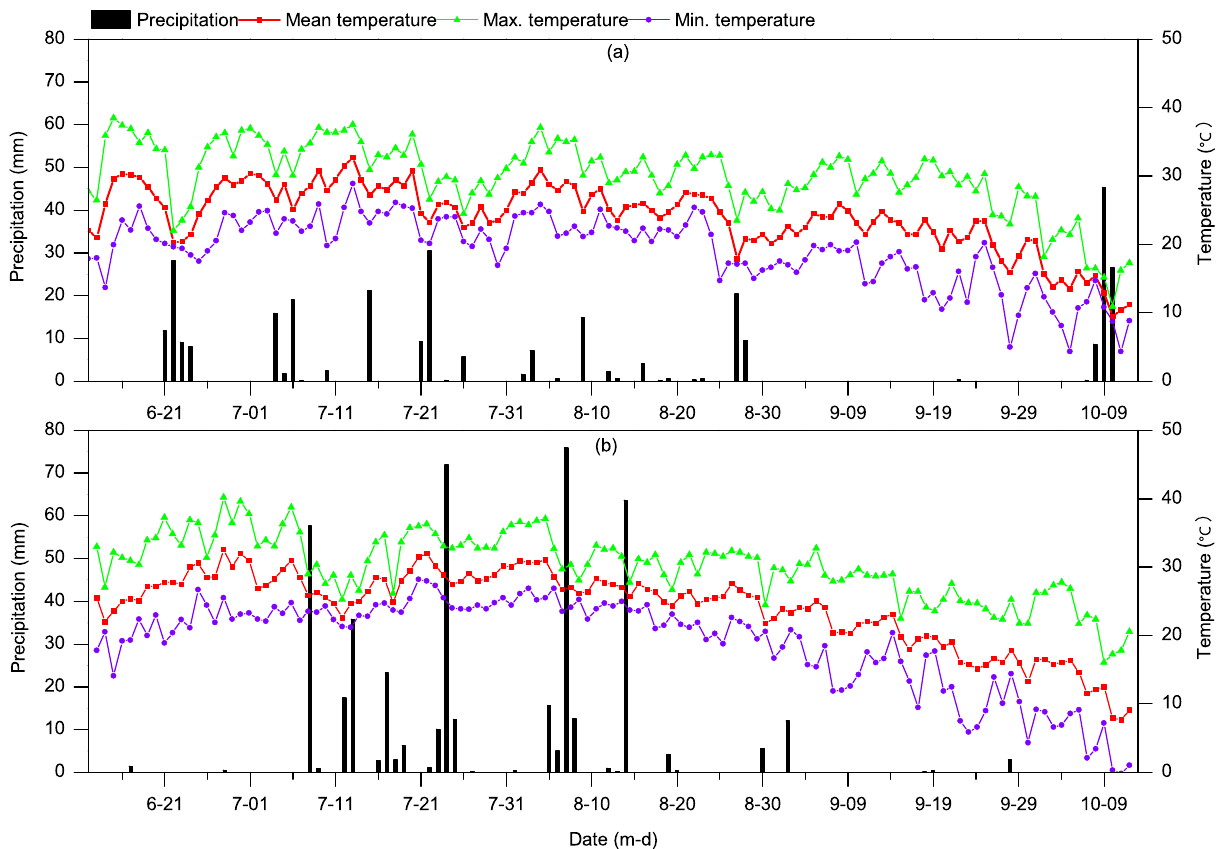
Figure 1. Daily precipitation and temperature of the experimental field during the summer maize growing seasons in 2017 ( a ) and 2018 ( b ). Graphs were created using Origin software version 2021 (Origin Lab Ltd.,